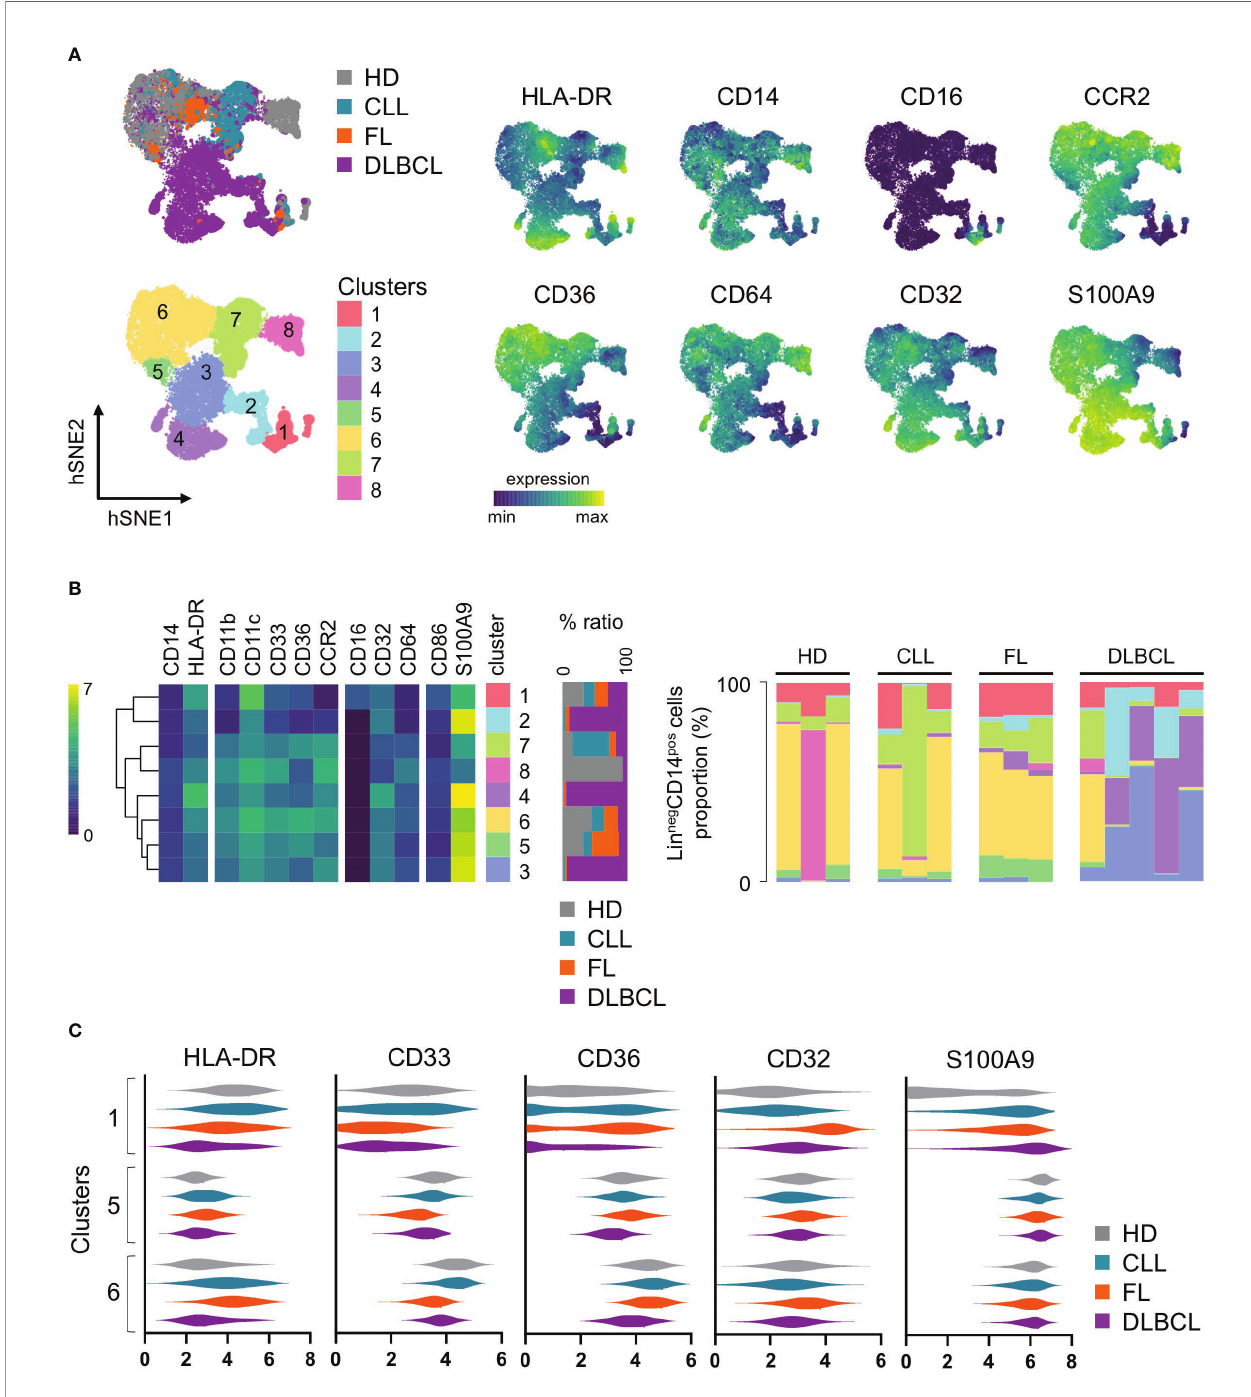
FIGURE 1 | Peripheral blood mononuclear cells (PBMC) from healthy donors (HD, n = 3), follicular lymphoma (FL, n = 3), diffuse large B-cell lymphoma (DLBCL, n = 5) and chronic lymphocytic leukemia (CLL, n = 3) patients were stained with a CyTOF panel already published and dedicated to regulatory myeloid cells assessment (9, 46). Lin neg CD14 pos viable cells were selected by manual gating on hSNE for each sample, using all channels and the default settings on Cytosplore (47, 48). Then, a hSNE algorithm followed by clustering was performed on all pooled selected cells (n=79,760) with Cytosplore (47, 48) using the following channels: CD11b, CD64, CD36, CCR2, CD45RA, CD123, CD86, CD33, CD11c, CD14, CD32, HLA-DR, CD16, and S100A9 and the default settings. Eight clusters were identi fi ed. (A) hSNE plot of CD14 pos myeloid cells, colored by sample type, clusters, and selected marker expression. (B) Heatmaps of selected markers in each cluster (left), relative distribution of the cells contained in each cluster per sample type (middle), and relative proportion of each cluster in each sample (right). (C) Violin plots of selected markers on clusters 1, 5, and 6 for each sample type. Expression values are arc-sinh transformed. Hierarchical clustering, heatmaps and violin plots were generated with R v3.6.3, using Rstudio v1.2.5033 and the pheatmap package, and Graphpad Prism